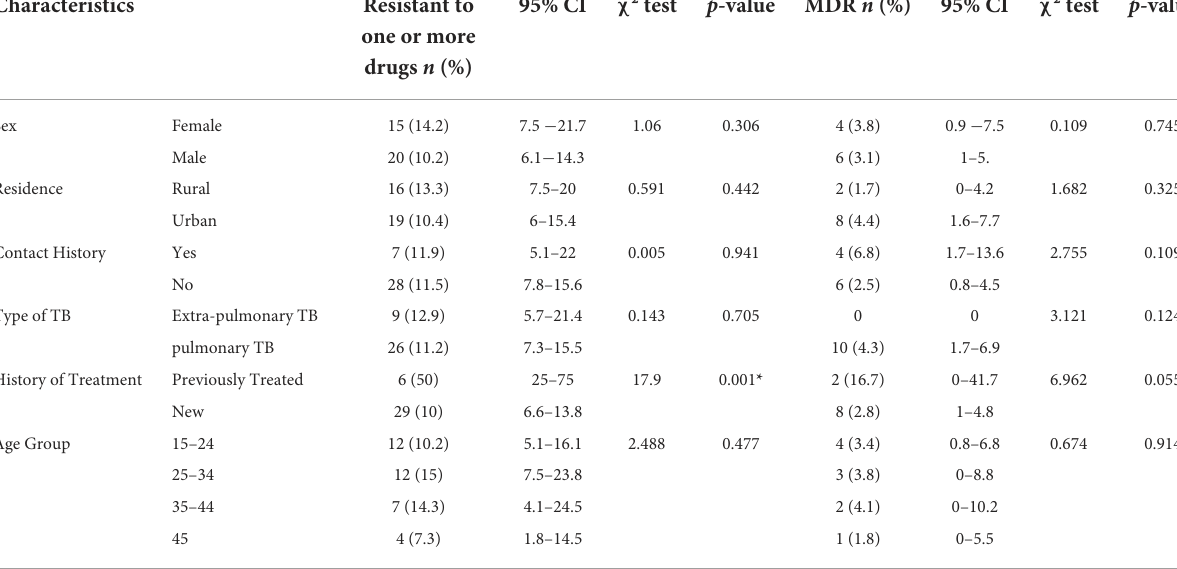
TABLE 2 Demographic characteristics and their relationship with drug resistance in patients with TB in Somali region, Ethiopia ( n = 302). Characteristics